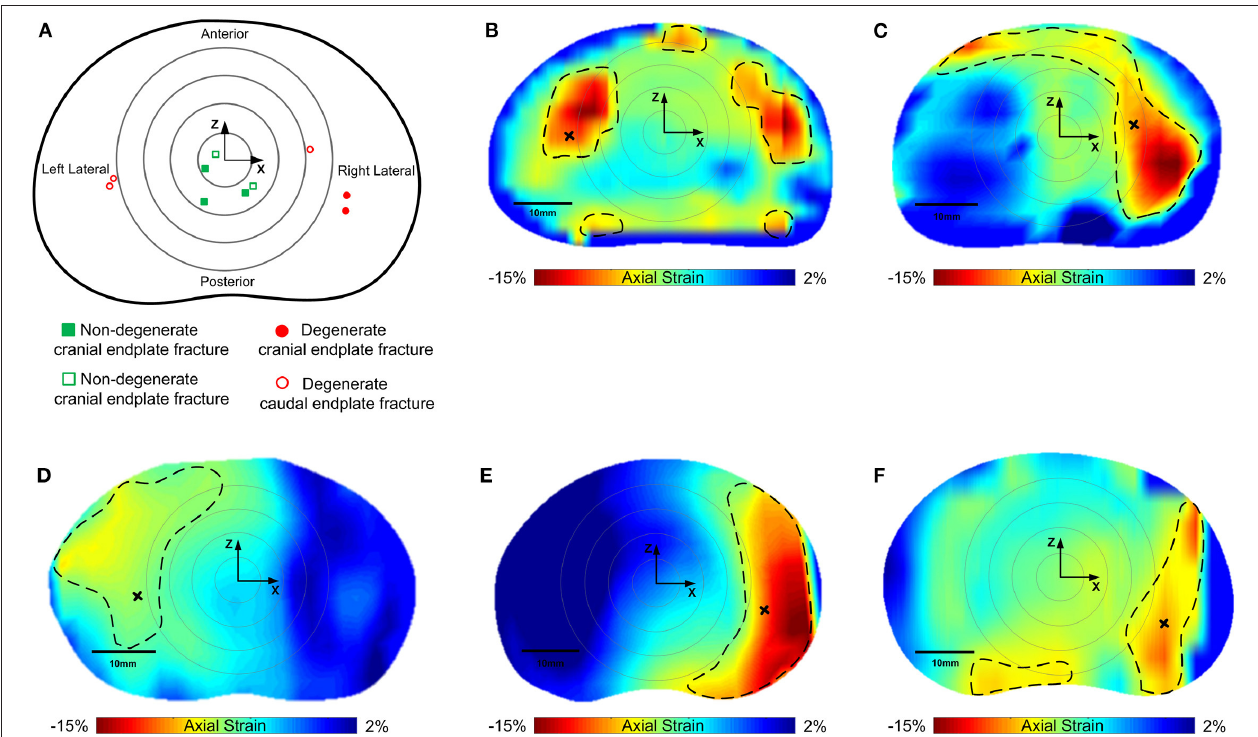
FIGURE 8 | (A) Normalized locations of endplate fracture in each of the samples tested. Squares (green) are non-degenerate samples, circles are degenerate (red). Solid points are cranial, and hollow points represent caudal endplate fracture. Concentric rings represent zones 20, 40, 60, and 80% of the distance between the furthest of either the most anterior or the most superior points of the vertebral body in the sagittal plane. (B–F) are axial strain distributions in the transverse plane of the degenerate IVDs overlaid by the location of endplate fracture. Non-degenerate discs are not shown as there was no correlation between regions of high axial strains and fracture location. Regions inside of the dashed lines indicate the high axial strain regions, and the areas outside represent low axial strain regions. Black crosses denote locations of fracture in the strain